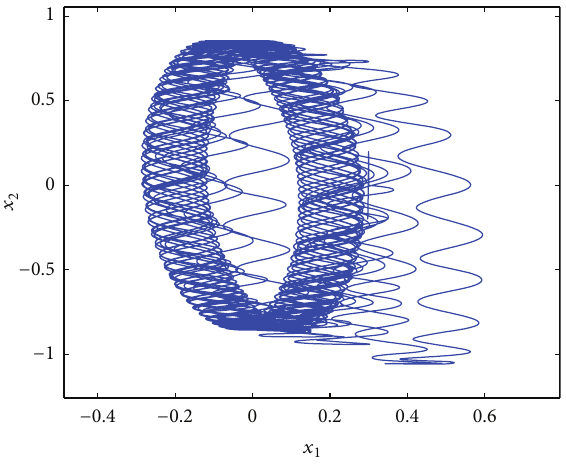
Figure 1: Phase trajectory of model (1).